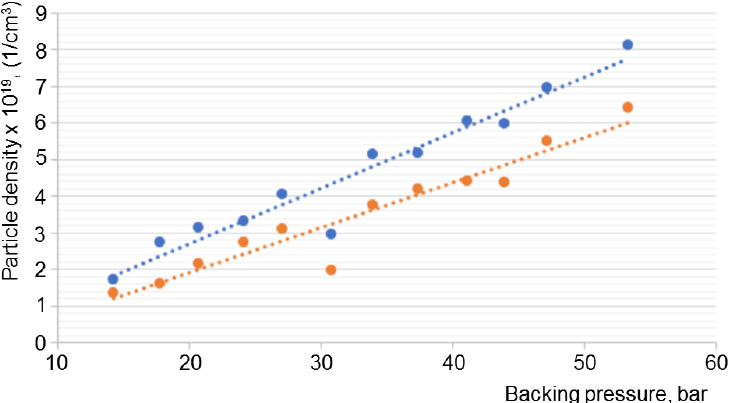
Figure 14. Maximum particle density for different backing pressure values between 17.8 and 53.4 bar [37]. The data are for 500 µ m (blue dots) and for 1000 µ m above the nozzle edge (brown dots).